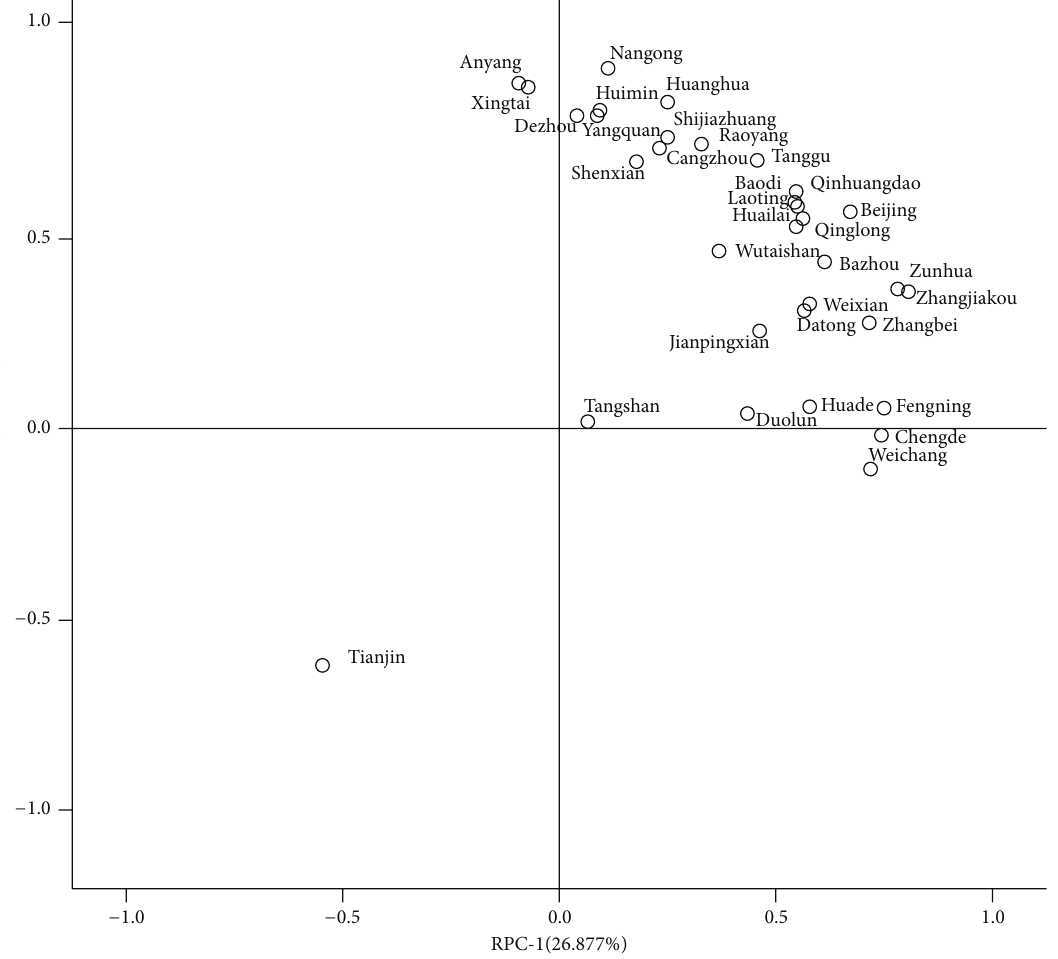
amount of precipitation in the area and mostly intensive agriculture. The R1 and R2 had the monthly precipitation values above average, while R3 had the precipitation values under average of